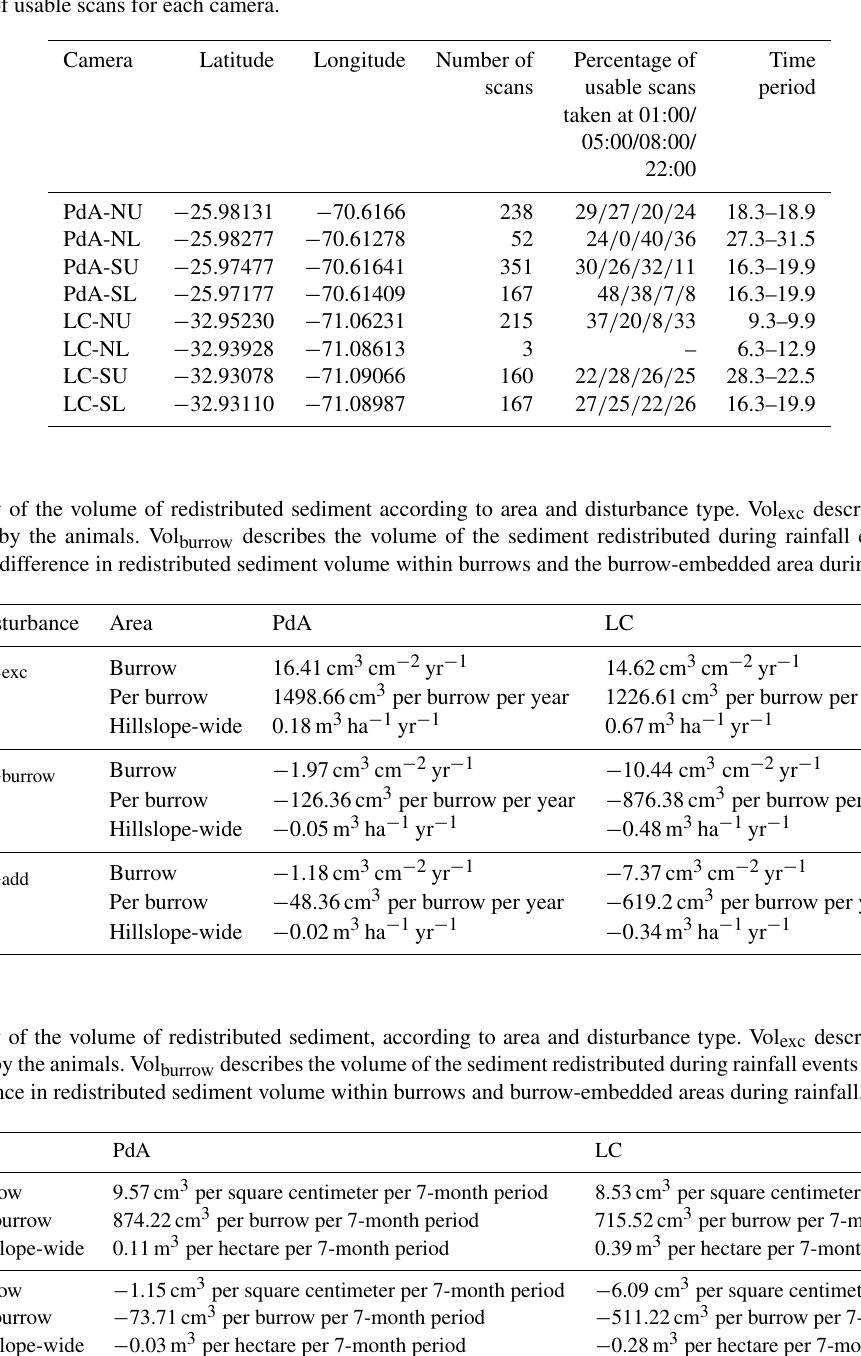
Table A2. Number of usable scans for each camera.